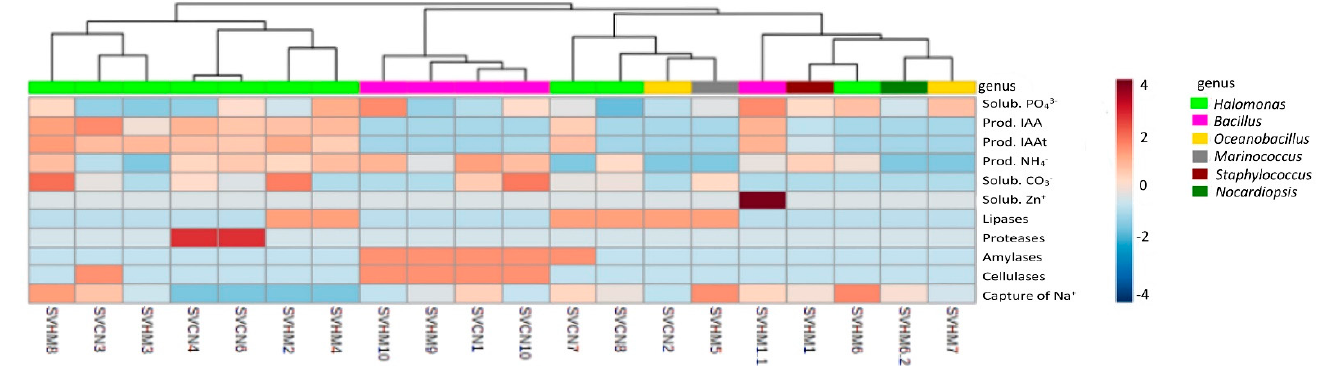
Figure 2. Heat map of the characteristics of plant growth promotion and enzymatic activity of bacte- rial isolates associated with the root soil of S. verrucosum . Phosphate solubilization (Solub. PO 43 − ); Tryptophan-independent IAA production (Prod. IAA); Tryptophan-dependent IAA production (Prod. IAAt); Ammonium production from organic sources (Prod. NH 4+ ); Carbonate solubilization (Solub. CO 3 − ); Zinc solubilization (Solub. Zn + ); Sodium capture capacity (Capture of Na + ). The values of the scale range from − 4 to 4; values close to − 4 indicate no capacity and values close to 4 indicate high capacity for some of the corresponding